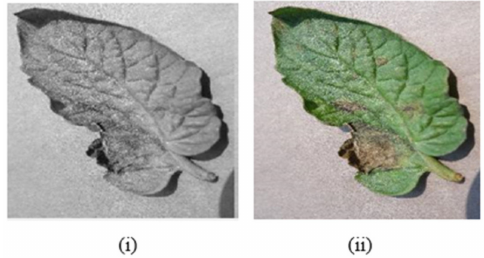
Figure 6. Effect of enhancement before ( i ) and after ( ii ).